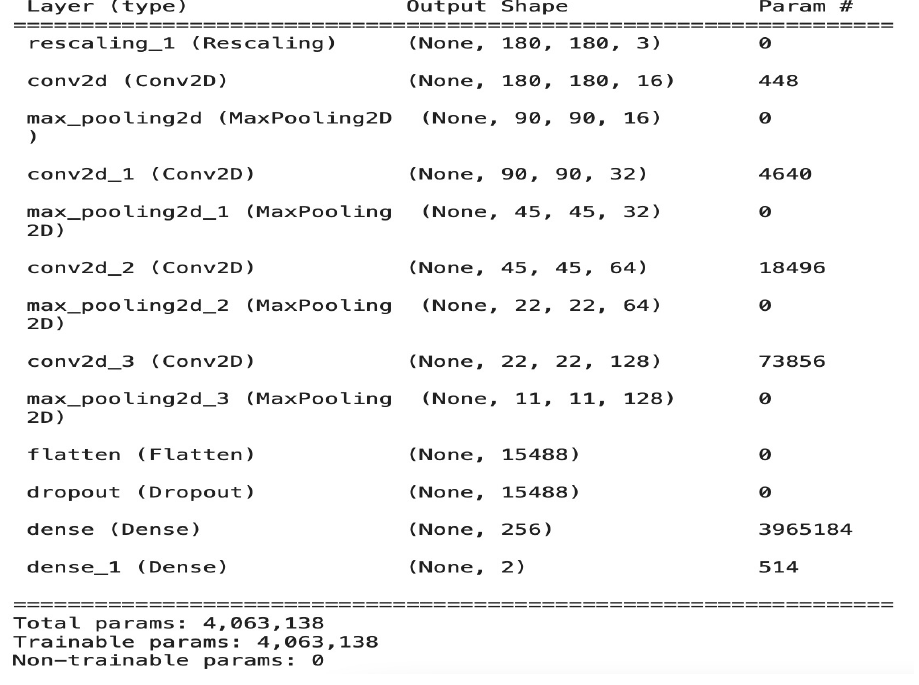
Figure 3. Summary of our deep model (the output shape and number of parameters in each